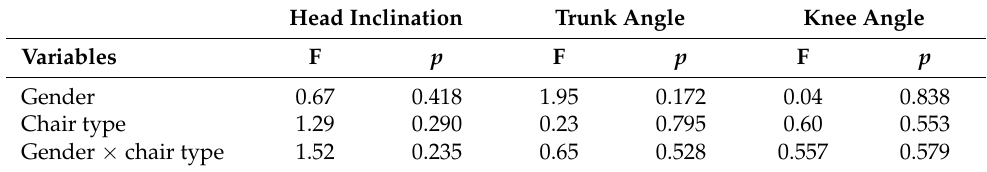
Table 2. Two-way ANOVA results for the ranges of joint angles calculated from 5 repeated trials.